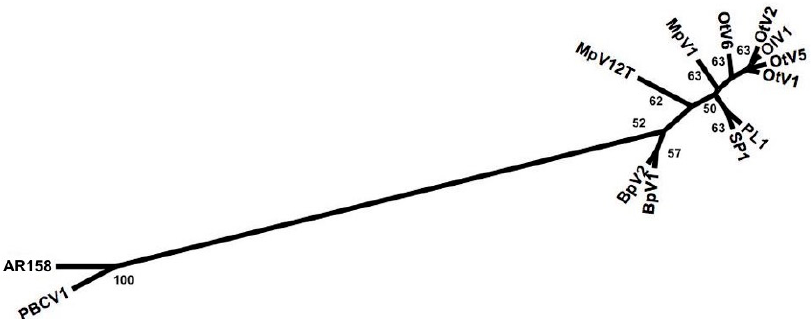
Figure 3. Phylogeny of prasinoviruses infecting the genera Ostreococcus (OtV1, OtV2, OtV5, OtV6,